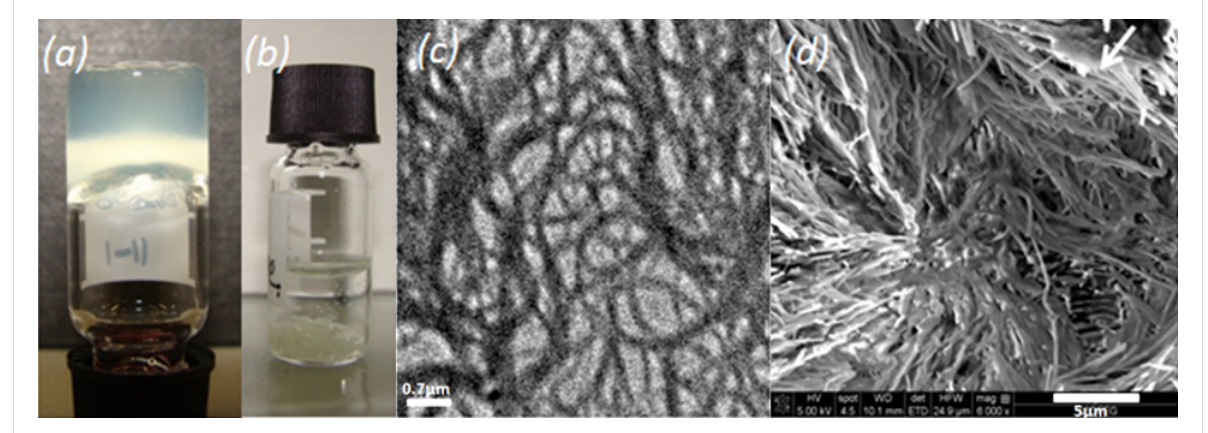
Figure 2: a) R - 3 gel in octane (5 mM); b) octane solution containing a mixture of R - 3 (2.5 mM) and S - 3 (2.5 mM) after cooling from 80 °C to room temperature; c) TEM image of the xerogel of R - 3 in octane; d) the surface morphology of the dried gel obtained from R - 3 in octane (15 mM) observed by